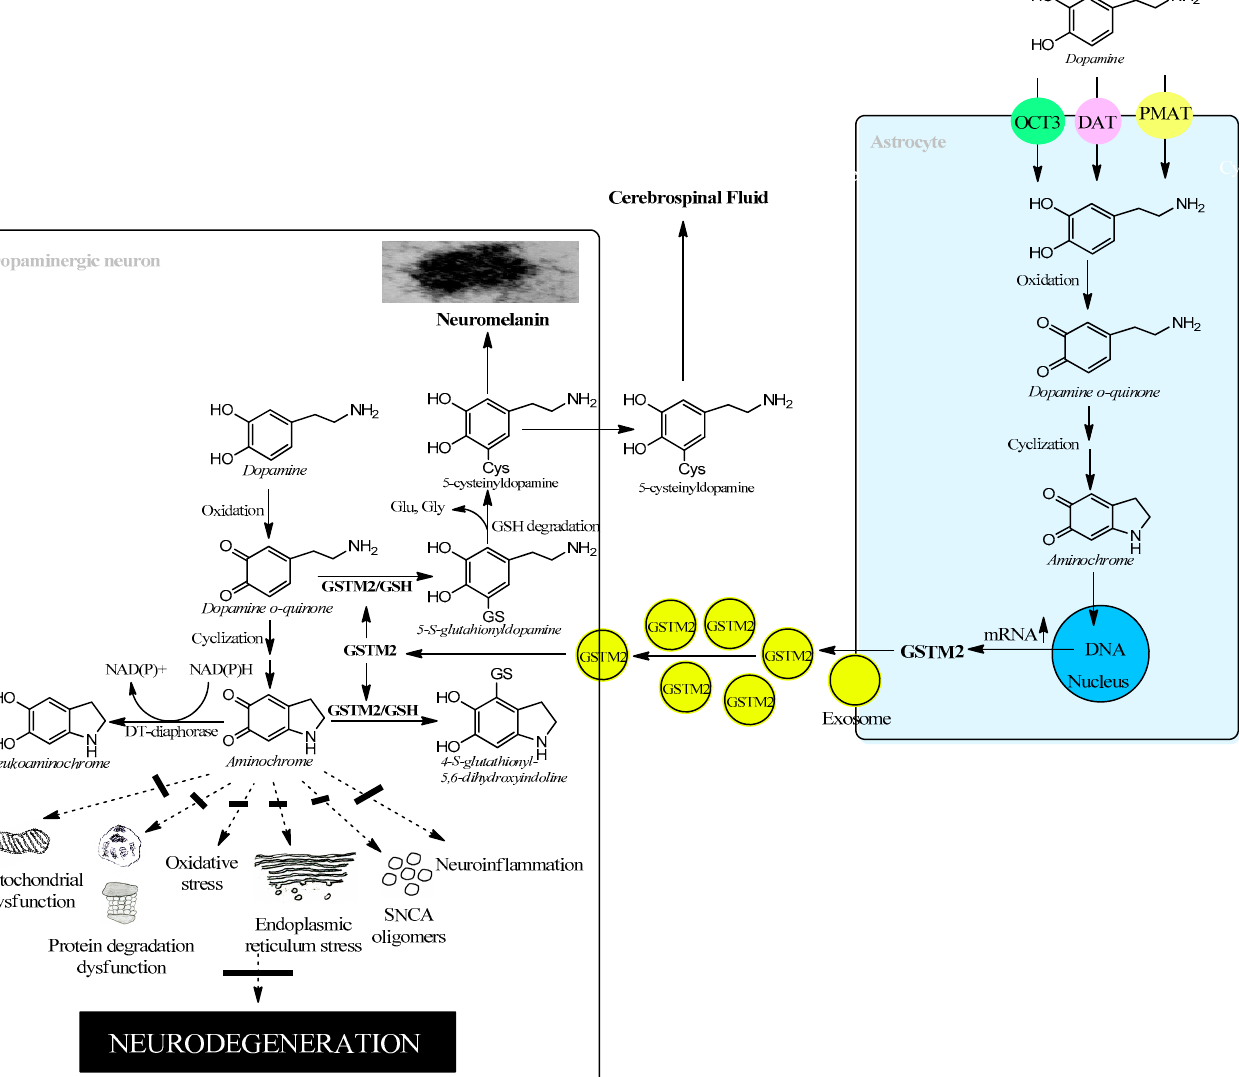
Figure 4. Astrocytes protect dopaminergic neurons against aminochrome neurotoxicity.